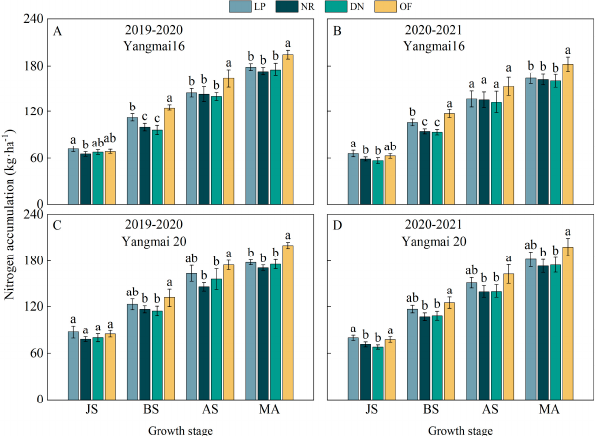
Figure 5. Effect of integrated cultivation practices on nitrogen accumulation of two wheat cultivars Yangmai 16 ( A , B ) and Yangmai 20 ( C , D ). LP, NR, DN, and OF indicate local practices, nitrogen reduction, planting density reduction and nitrogen reduction, and organic fertilizer, respectively. JS, BS, AS, and MA indicate the jointing stage, booting stage, anthesis stage, and maturity, respectively. Vertical bar represents the ± standard error of the mean. Different lowercase letters indicate the same period; the difference between different treatments was significant at the 0.05 level.